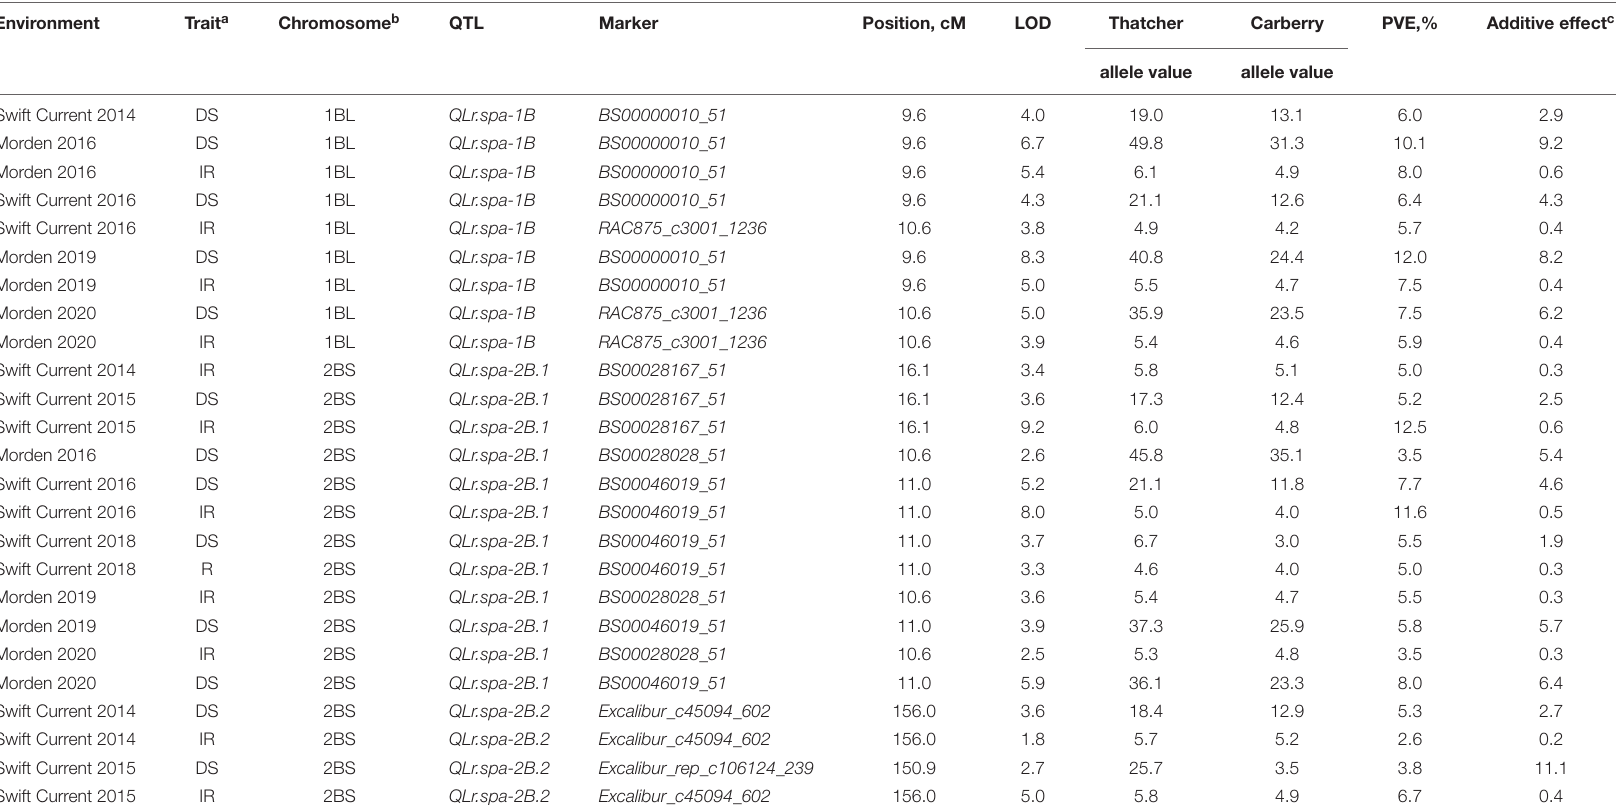
TABLE 5 | Quantitative trait loci (QTL), their chromosome arm location, peak associated marker and LOD, position on the chromosome in centiMorgans (cM), phenotypic value associated with the parental type allele, percent of phenotypic variation explained (PVE%), and additive effect associated with response to leaf rust disease severity and infection response detected in the Carberry/Thatcher population evaluated in field nurseries near Morden, MB, and Swift Current,